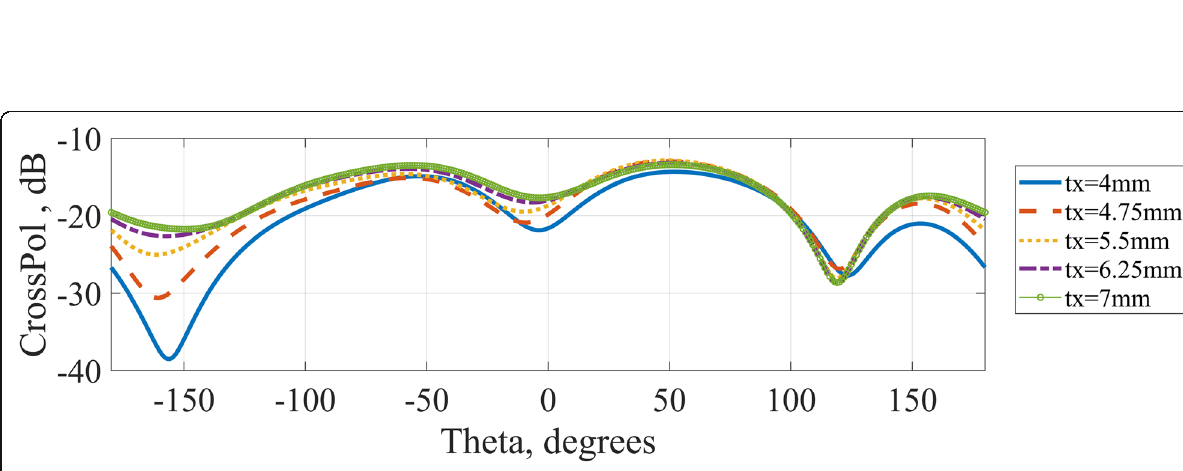
Fig. 5 Effect of the variation of tx (transition width) on cross-polar level for Phi0